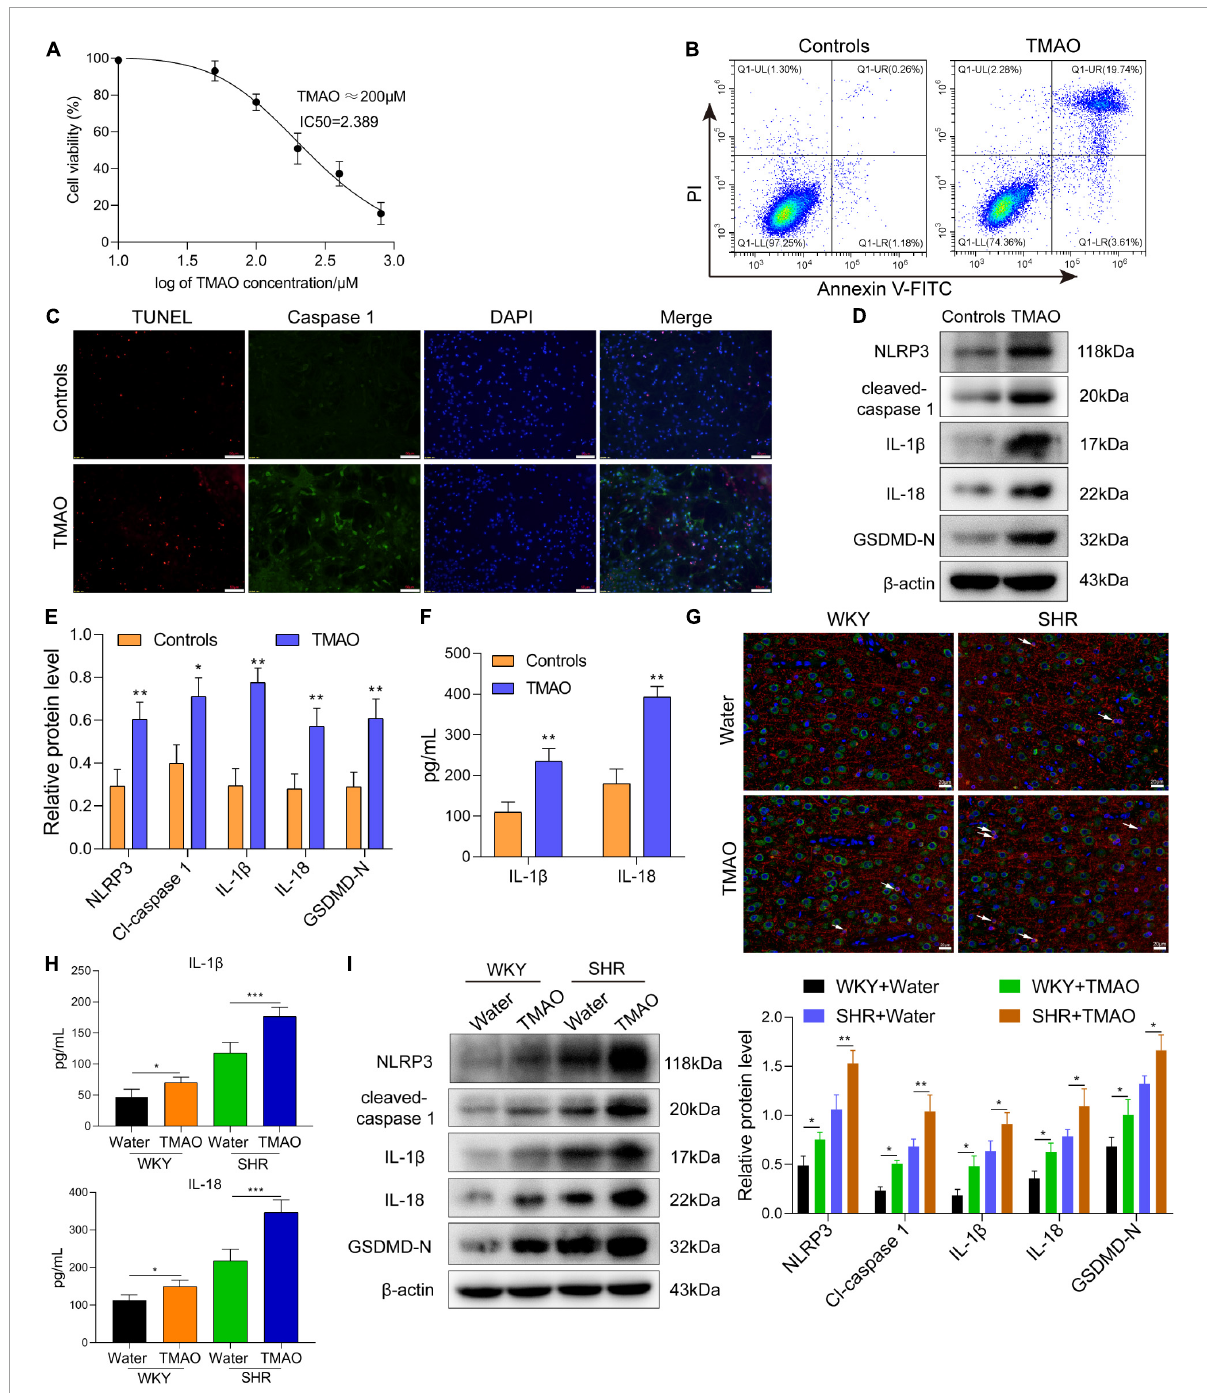
FIGURE3 TMAO induced pyroptosis of oligodendrocytes to enhance demyelination in SHR. (A) CCK-8 kit was used to measure the cell viability of oligodendrocytes treated with TMAO. (B) Flow cytometry based on Annexin V-FITC/PI staining was used to detect the proportion of apoptotic cells. (C) Immunofluorescence assay for TUNEL (red) and caspase-1 (green) was carried out to measure the change of cell death. DAPI (blue) was used to stain neuclus. Scale bar = 50 µ m. (D) The expressions and (E) quantitation of NLRP3, IL-1 β , IL-18, cleaved-caspase 1 and GADMD-N terminal in cells were detected via western blot. (F) The levels of IL-1 β and IL-18 in conditional medium were detected by ELISA assay. (G) GSDMD (green) and MBP (red) double staining immunofluorescence analysis in white matter region was performed. Arrows were for GSDMD + MBP + oligodendrocytes in cerebrum. Scale bar = 20 µ m. (H) The levels of IL-1 β and IL-18 in CSF were detected by ELISA assay. (I) The expressions of NLRP3, IL-1 β , IL-18, cleaved-caspase 1 and GADMD-N terminal were detected via western blot. The data were expressed as mean ± SD of three independent experiments. * P < 0.05, ** P < 0.01, *** P <